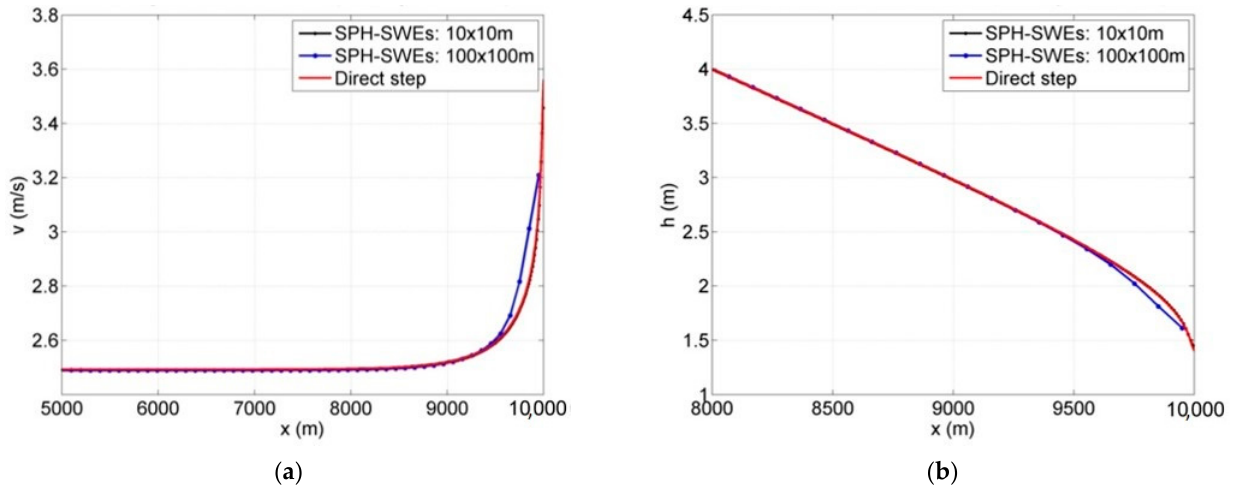
Figure 7. Results of 1D simulation for M2 curve longitudinal profile view: ( a ) velocity and ( b ) water level.